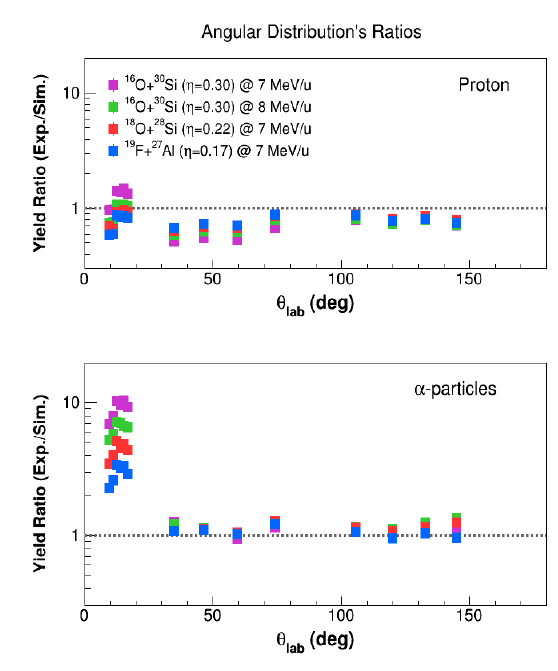
Fig. 2. GEMINI ++ simulated angular distribution of protons (upper panel) and  -particles (lower panel) for the four studied reactions. The distributions are normalized to the number of complete events.